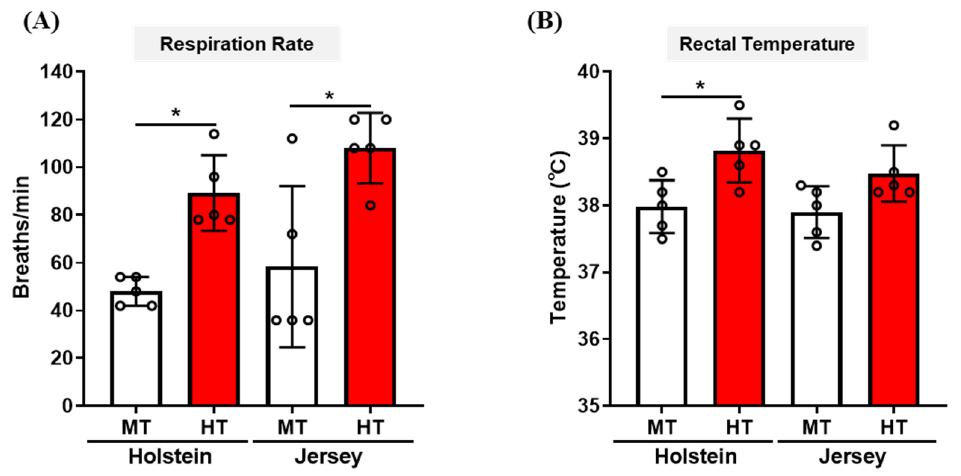
Figure 1. Physiological responses of Holstein and Jersey cows to differential seasonal environment. Measurements of respiration rate ( A ) and rectal temperature ( B ) for Holstein and Jersey cows in MT condition (THI = 69.6) and HT condition (THI = 87.5). Data are represented as mean ± SD; n = 5 animals/group. Values were statistically analyzed by repeated measures two-way ANOVA with Tukey’s multiple comparison test. * p < 0.05; MT, moderate THI season; HT, high THI season.